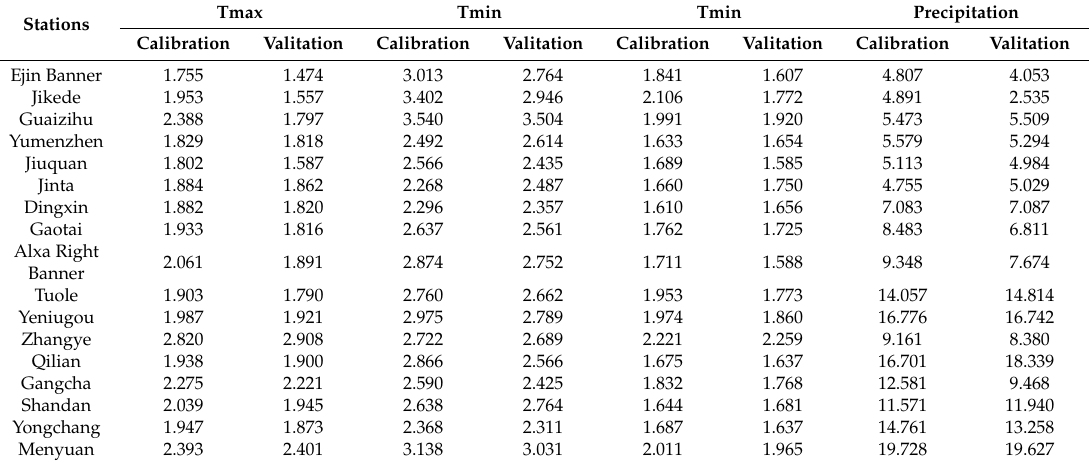
Table 5. Root mean square error ( RMSE ) results of the SDSM during calibration and validation periods. Stations